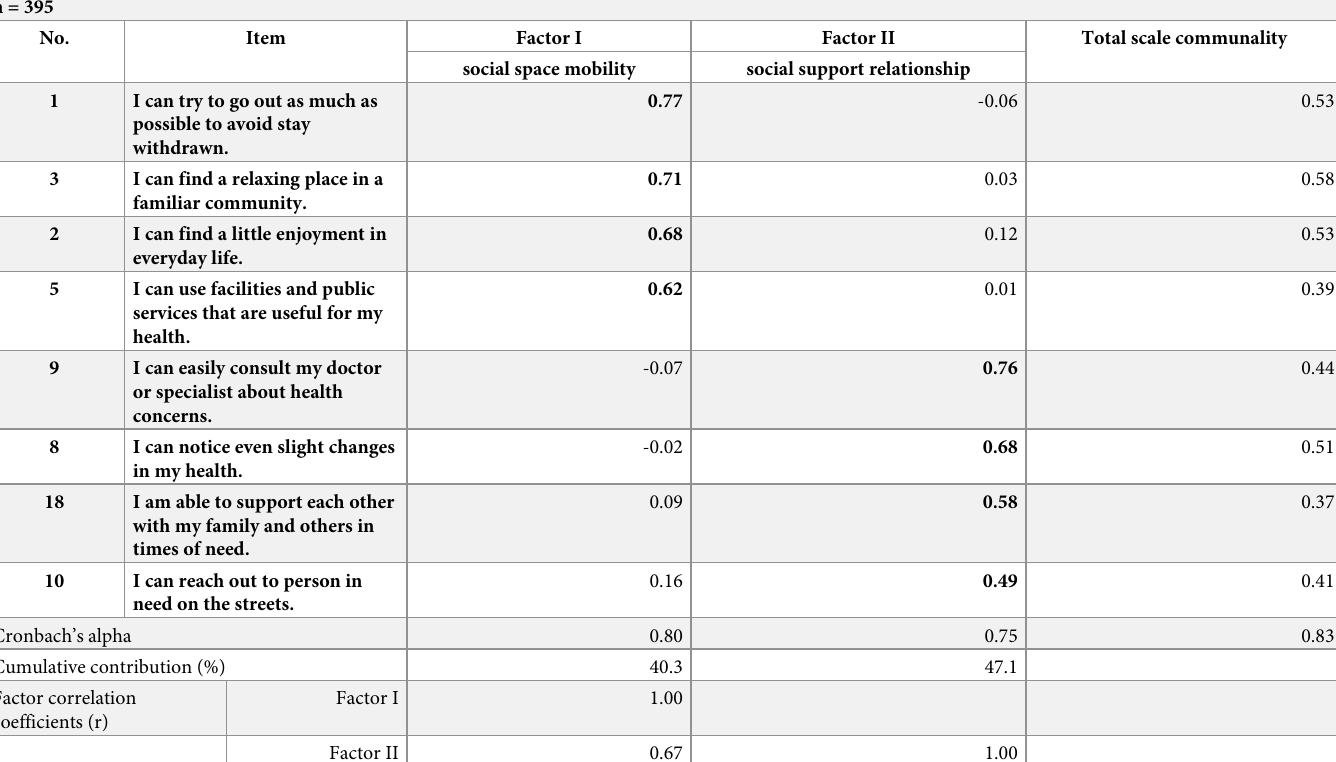
Table 3. Exploratory factor analysis of the “social contact self-efficacy scale for third